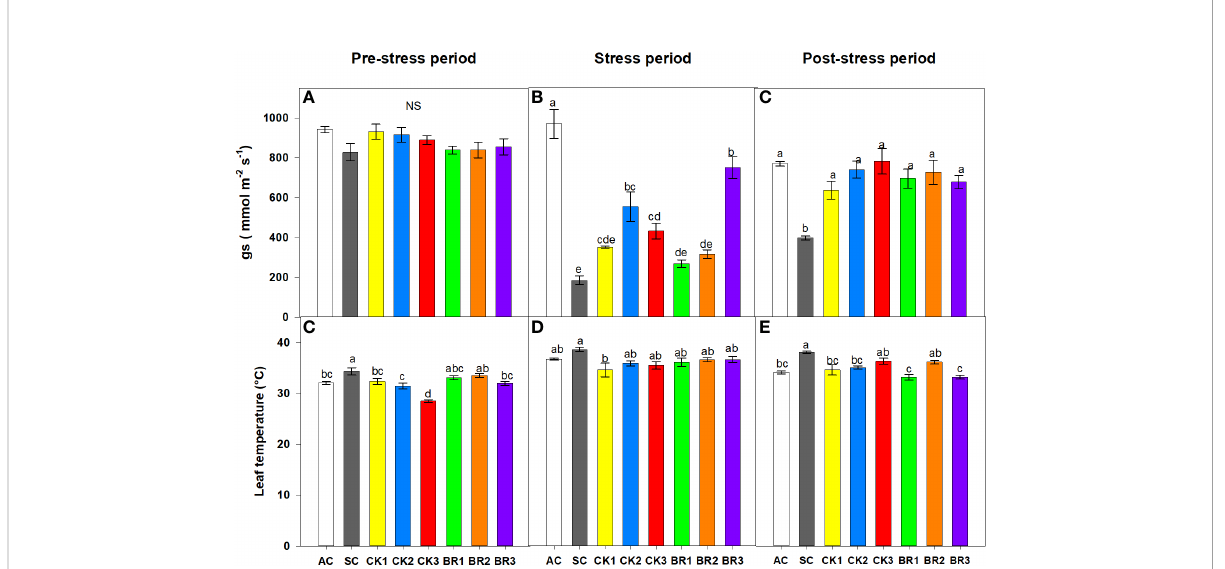
FIGURE 4 Effect of the number of applications of two growth regulators (cytokinins (CK) or brassinosteroids (BR)) on stomatal conductance (g s ) before the stress period (A) , end of the stress period (B) , and after the stress period (recovery) (C) , and leaf temperature before the stress period (D) , during the stress period (E) , and after the stress period (recovery) (F) in rice plants of genotype F2000 subjected to combined heat stress (40°C day/30°C night) at 88 days after emergence (DAE). The treatments evaluated were as follows: absolute control (AC), heat stress control (SC), one foliar spray of CK (CK1), two foliar sprays of CK (CK2), three foliar sprays of CK (CK3), one foliar spray of BR (BR1), two foliar sprays of BR (BR2) and three foliar sprays of BR (BR3). Each column represents the mean of fi ve data ± standard error (n = 5). Bars followed by different letters indicate statistically signi fi cant differences according to Tukey ’ s test (P ≤ 0.05). Equal letters indicate that the means are not statistically signi fi cant ( ≤